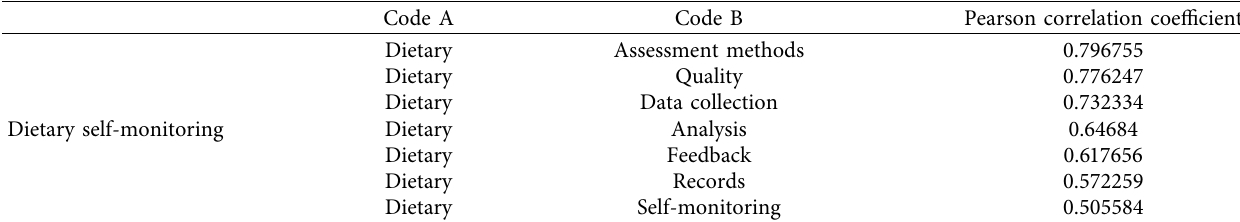
Table 5: Relation of the dietary